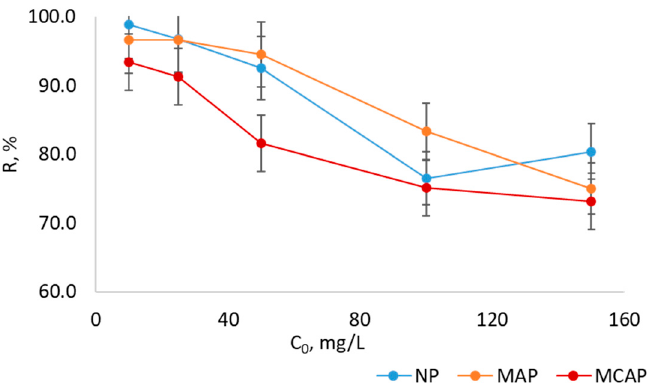
Figure 7. Removal percent of Cu(II) on three peat modifications at 30 min interaction time, pH 4.6 ÷ 3.2.